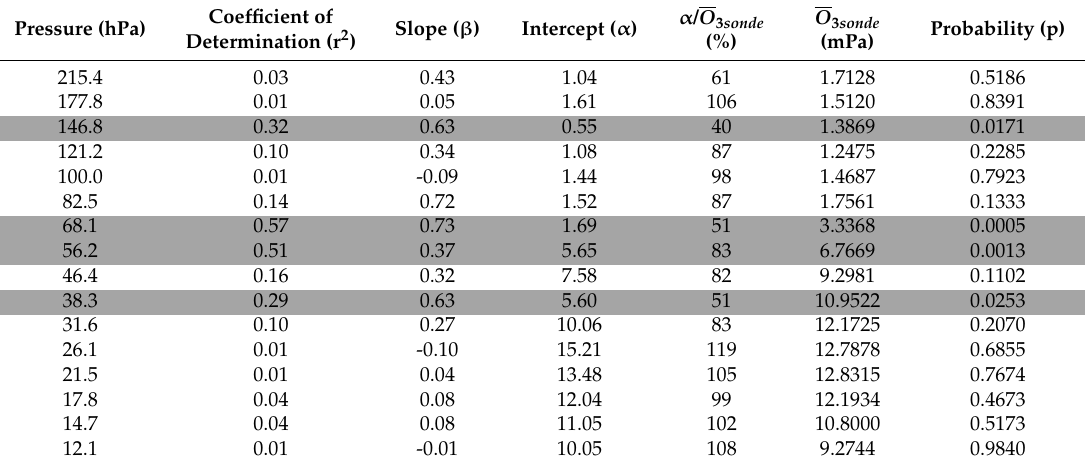
Table 1. Linear regression coefficients of MLS ozone and